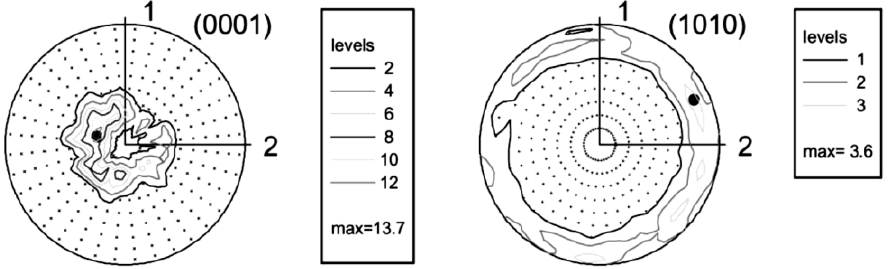
Figure 9. Intensity plots of pole figures (0001) and (1010) of high-purity Zirconium plates, reproduced from [32], with permission from Elsevier, 2001.